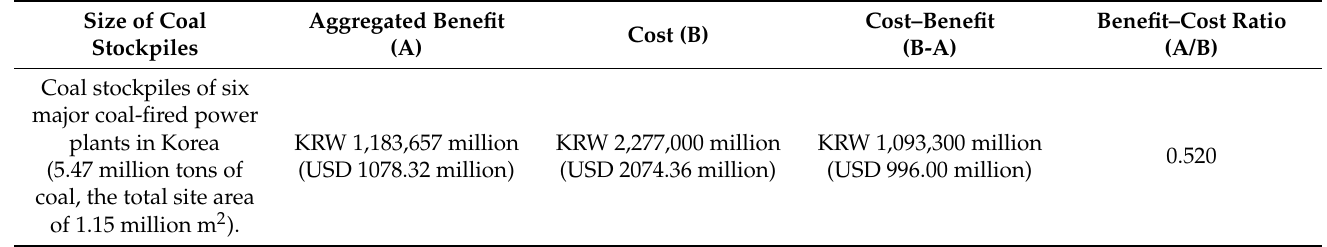
Table 7. Cost–benefit analysis for the project of building indoor coal